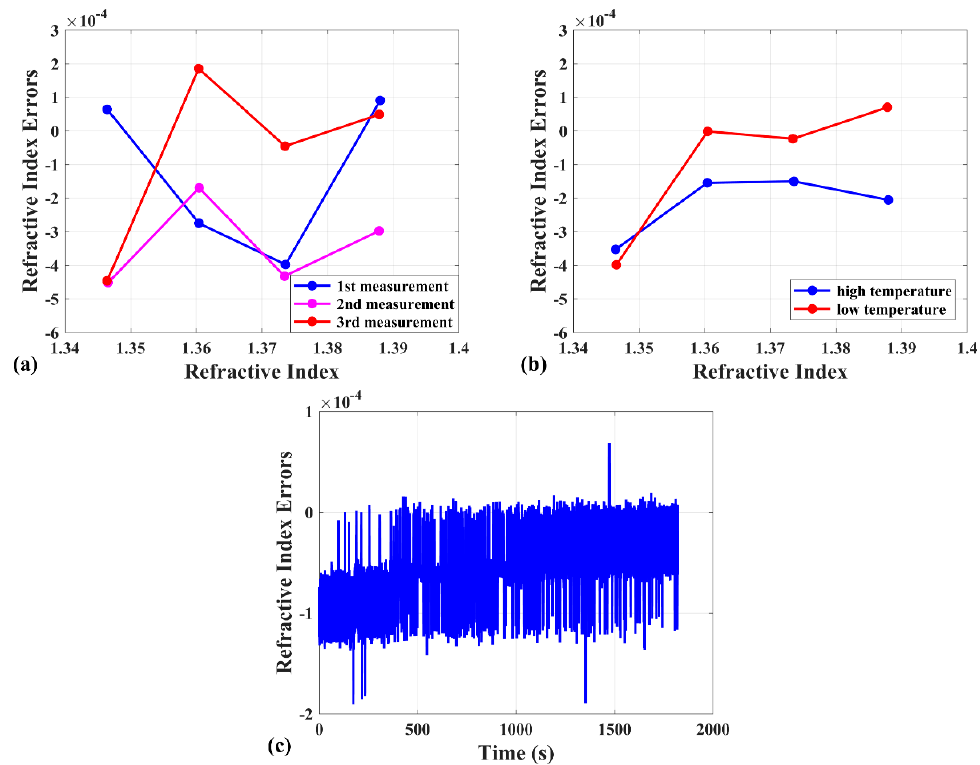
Figure 7. ( a ) The RI errors at three times of the repeating measurement. ( b ) The RI errors at two times of the temperature stability test. ( c ) The RI errors changes in 30 min in the RI = 1.36 liquid.